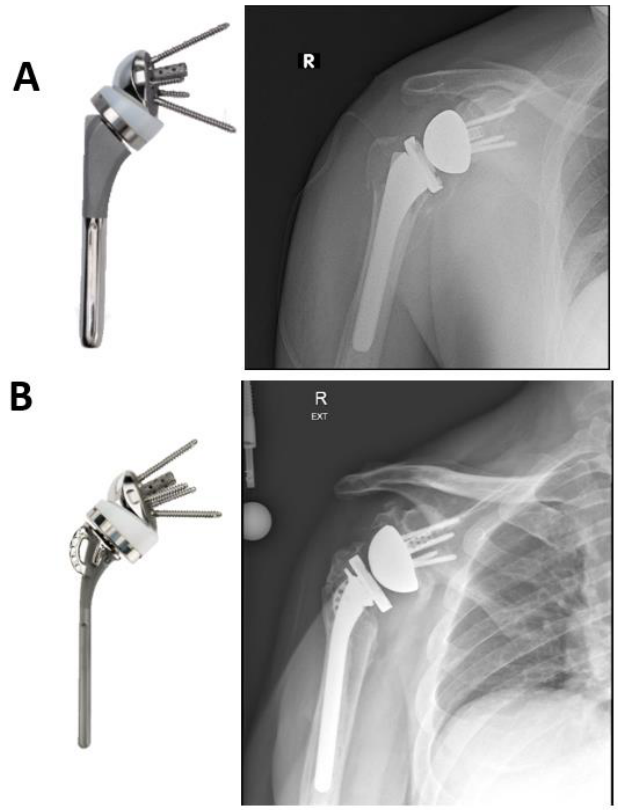
Figure 4. Conventional ( A ) and fracture specific ( B ) humeral stem.